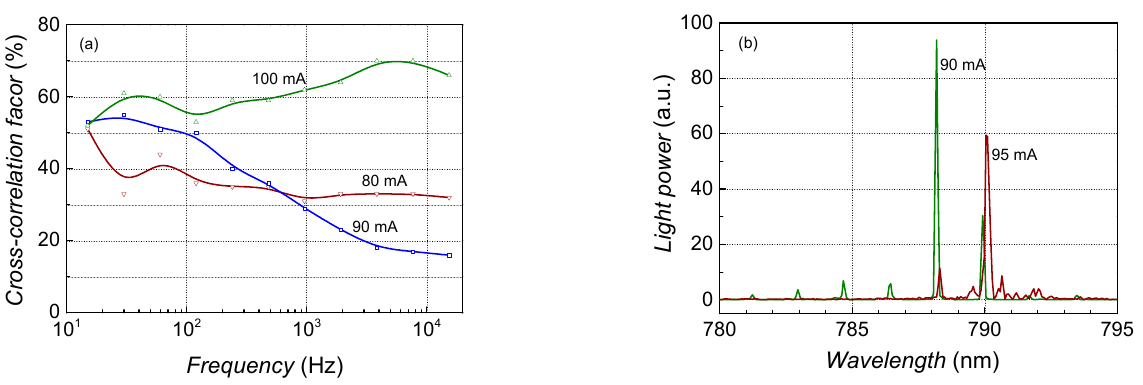
Figure 9. Cross-correlation factor dependency on frequency ( a ) and radiation spectra ( b ) of sample No. 4 during the mode-hopping effect (room temperature).